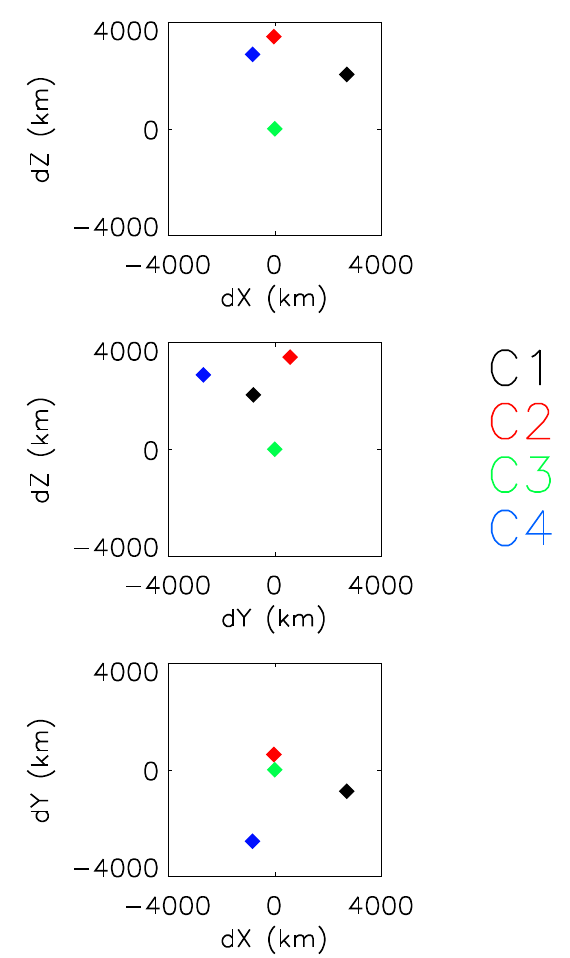
Fig. 6. The separations of each of the Cluster spacecraft from the reference position are shown in the GSM–XY, –XZ and –YZ planes. C1 to C4 are marked in black, red, green and blue respectively. The order of the spacecraft in the GSM–Z direction is the expected or- der the plasma sheet – lobe boundary should traverse the spacecraft